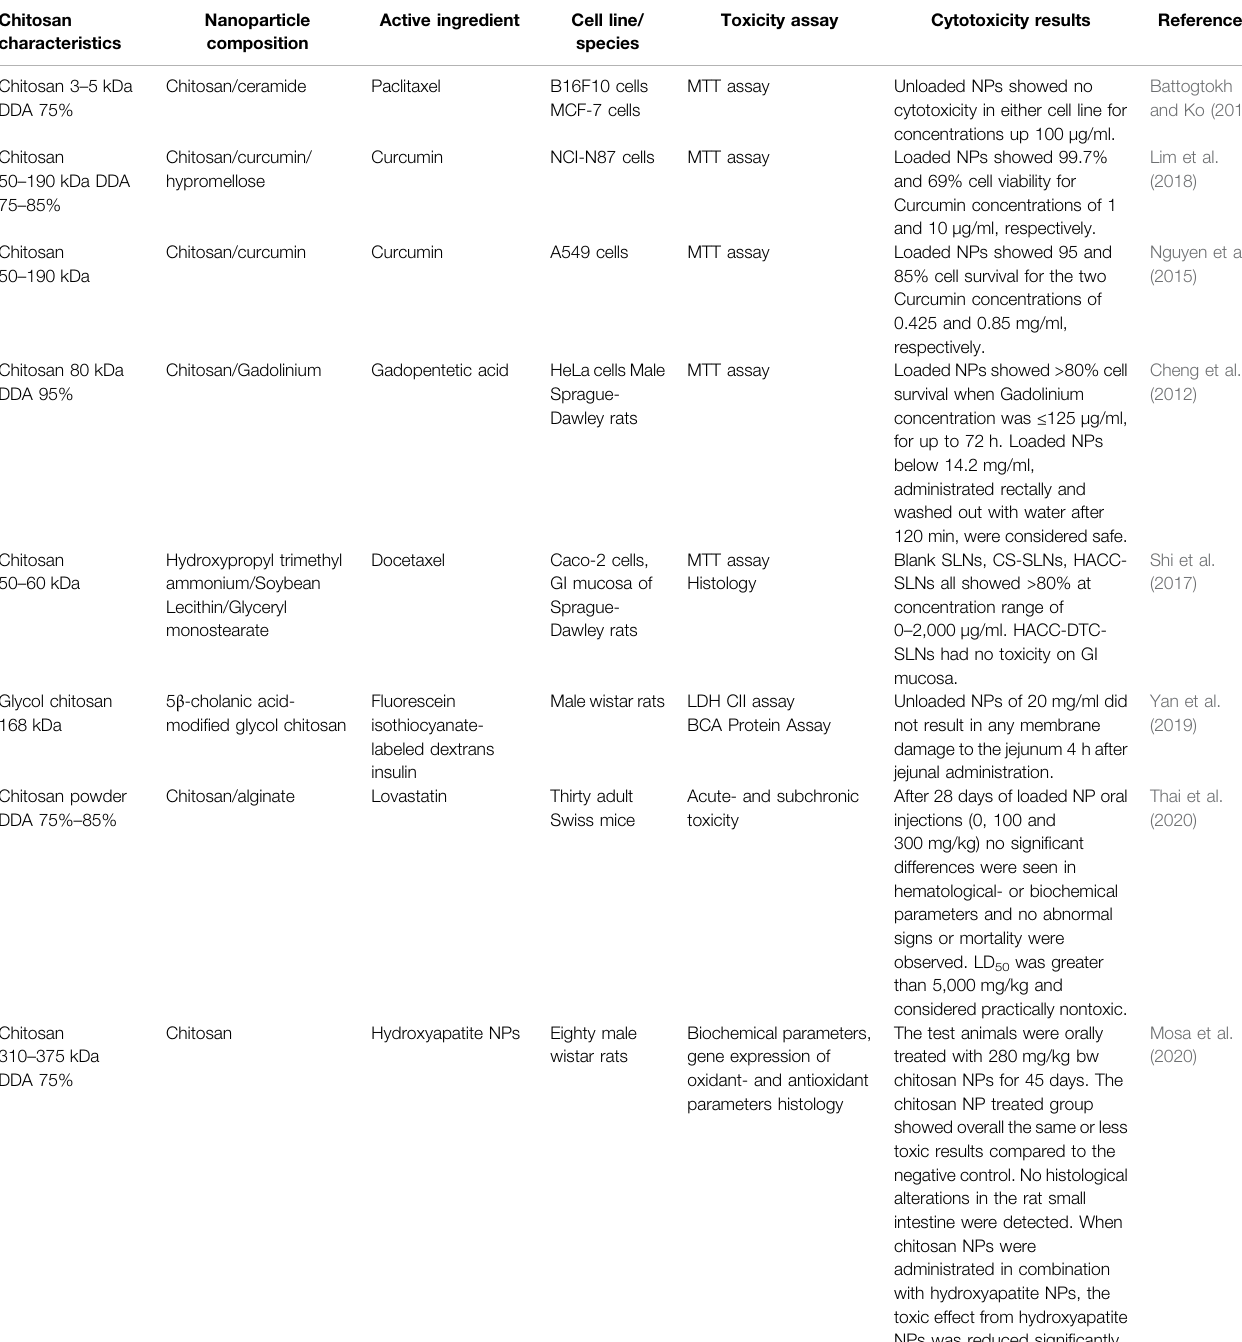
TABLE 8 | Articles on other derivatives and complexes with chitosan nanoparticles, main fi